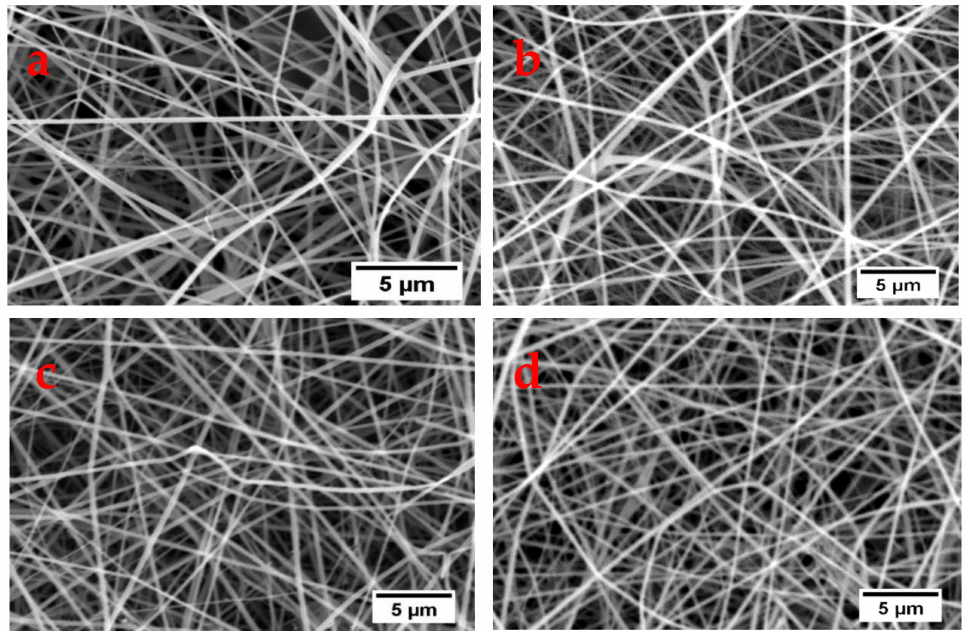
Figure 9. SEM images of nanofibers electrospun under optimum conditions from ( a ) CaCl 2 , ( b ) Ca(NO 3 ) 2 , ( c ) LiCl, and ( d )